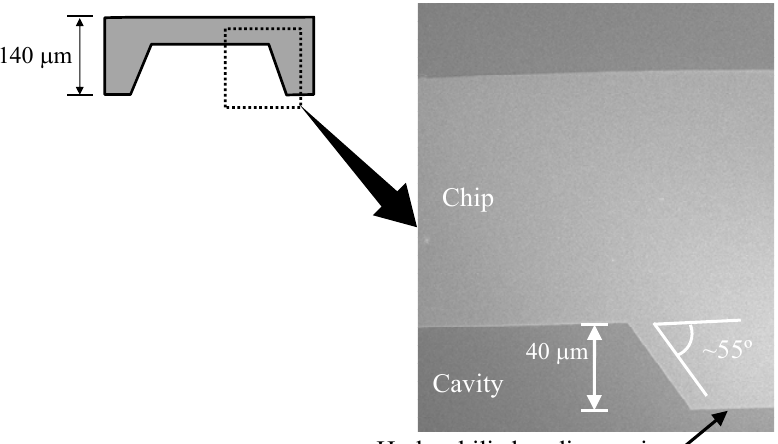
Cavity Hydrophilic bonding